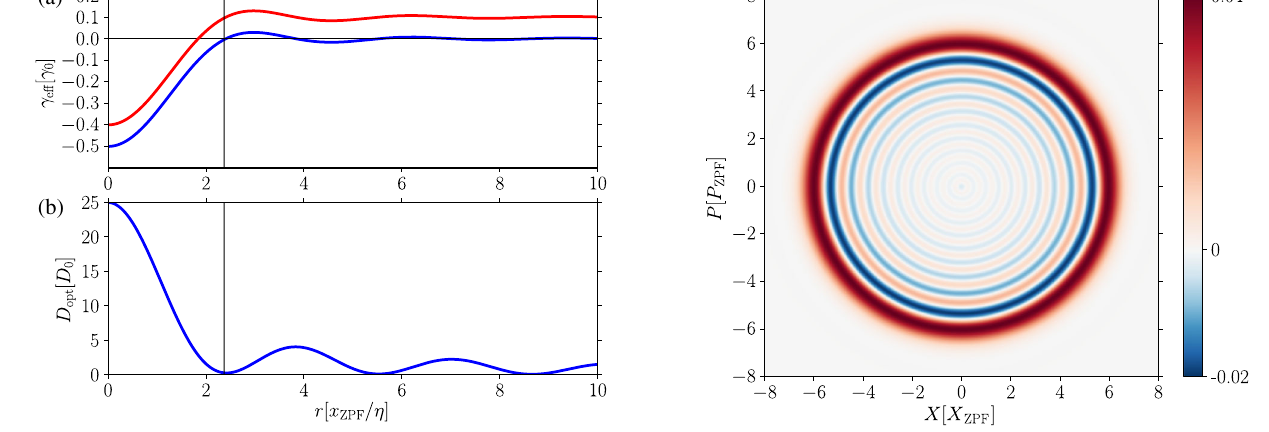
r Þ ¼ γ þ γ r Þ FIG. 1 (color online). (a)Effectivedamping γ FIG. 2 (color online). Wignerfunction W ofthelowestmetastable eff ð opt ð = ð 2 κ Δ = Δ 2 from Eq. (43) in units of γ 0 ¼ ð g 0 E 2 = ω 2 þ κ 2 Þ limit cycle of the mechanical oscillator for parameters ð g 0 ; κ m Þ eff E ¼ eff 2 κ ; γ ; E; Δ ; K Þ ¼ ð 0 . 275 ; 0 . 1 ; 0 ; 0 . 15 ; − 0 . 026 ; 0 . 076 Þ × ω versus cycle amplitude r in units of zero-point fluctuation and η . . As m The blue and red lines are two examples for different intrinsic there are fewer than 0.03 photons in the cavity, we are in the regime Δ þ K ; cf. Eq. (39). Choosing the bare dampings γ .Limitcyclesarestableatrootsofthetotaldampingwith of j α j 2 ≪ 1 , where Δ eff ¼ a positive slope. This condition is fulfilled only once for the red line detuning to minimize the Fano factor ( F ¼ 0 . 1 at the attractor with with γ ¼ 0 . 1 γ 0 ,correspondingtoonlyonepossibleamplitudeforthe lowest amplitude, which is depicted in this plot) implies that oscillation. For the blue line with γ ¼ 0 , many such intersections according to Eq. (50), Δ ¼ κ − K , which for the strong optome- occur and the oscillator amplitude will, in general, jump between chanical coupling of this examplegives thenegative numerical value Δ ¼ − 0 . 026 .NotethatclassicallyorexcludingtheKerreffect,alimit those different metastable points. (b) The optical part of the 0 . 1 and Δ κ diffusion from approximation (48) for κ = ω m ¼ eff ¼ in units of D 0 ¼ κ g 2 0 E 2 = ω 4 . Note that the dominant part of the W in this plot is − 0 . 02 m diffusion from Eq. (48) is exactly canceled at the position of the limit cycle for γ ¼ 0 , as indicated by the vertical line. This cancellation explains the strongly sub-Poissonian phonon sta- tistics for such parameters.